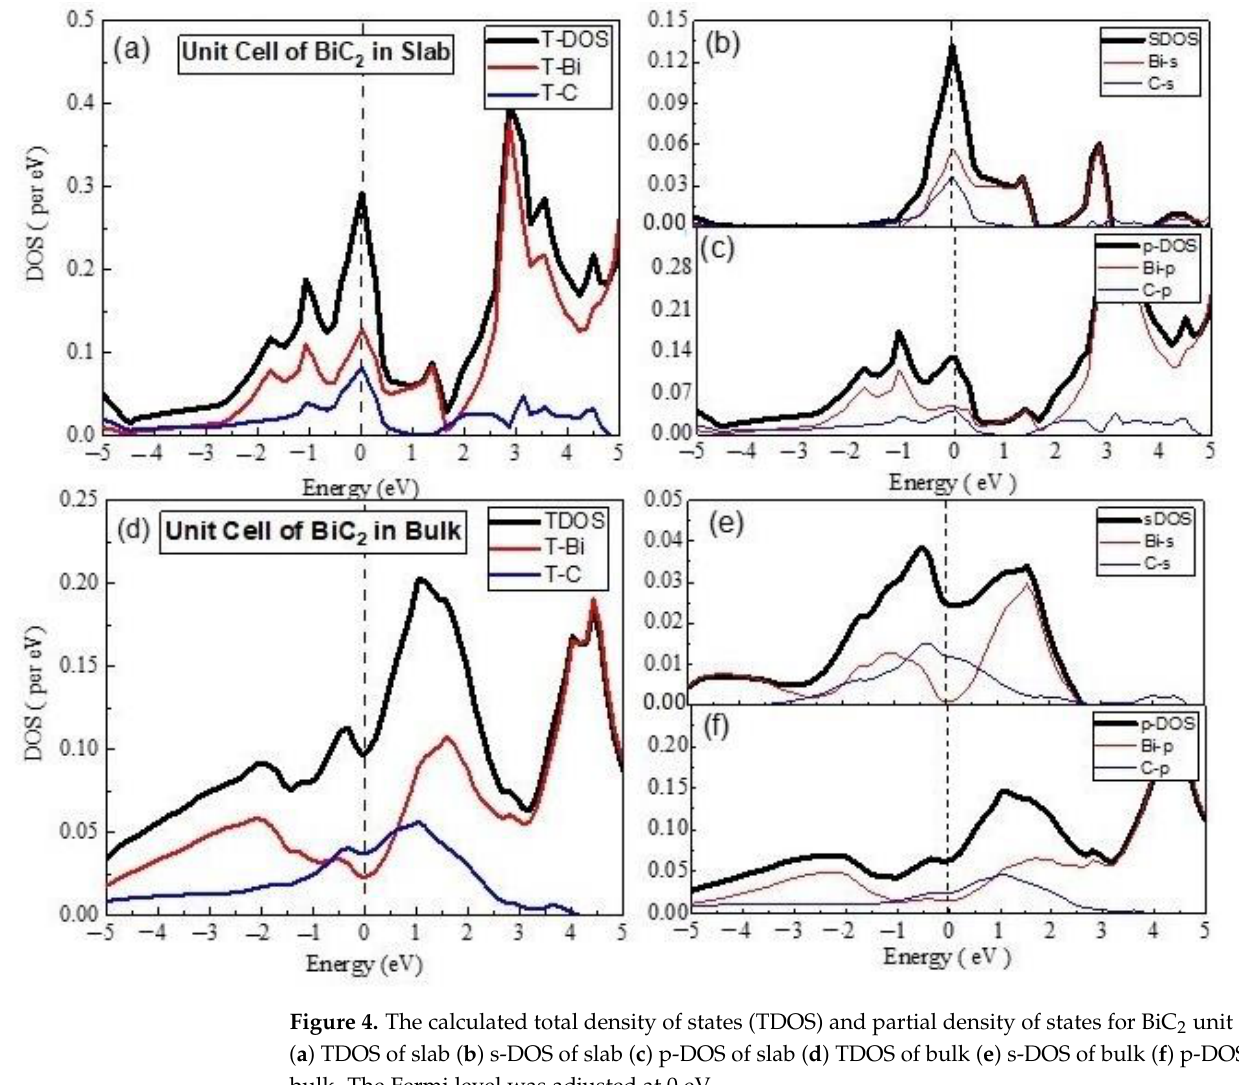
Figure 4. The calculated total density of states (TDOS) and partial density of states for BiC 2 unit cell ( a ) TDOS of slab ( b ) s-DOS of slab ( c ) p-DOS of slab ( d ) TDOS of bulk ( e ) s-DOS of bulk ( f ) p-DOS of bulk. The Fermi level was adjusted at 0 eV.